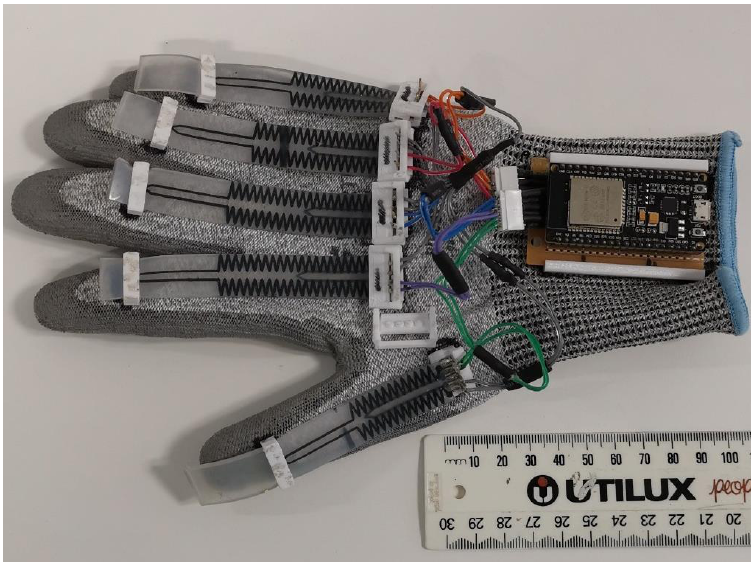
Figure 7. A completed data glove showing the stretch sensors connected to an Arduino board with a Bluetooth shield.